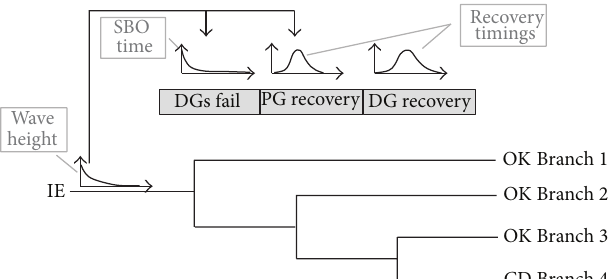
Figure 16: Representation as ET structure of the RAVEN/RELAP-7 simulation. Note that the parameter characterizing the initiating event, that is, wave height, affects timing of the ET branches (e.g., PG recovery time).